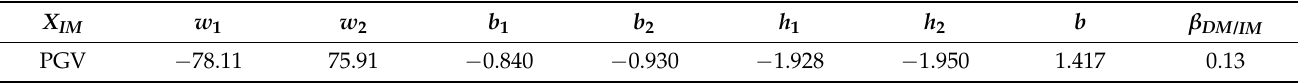
Figure 5. Framework to derive an ANN-based PSDM proposed by Huang et al. [73]. Table 2. Example of definition of an ANN-based PSDM : coefficients of the relating damage measures X DM with PGV (Huang et al. [73]).